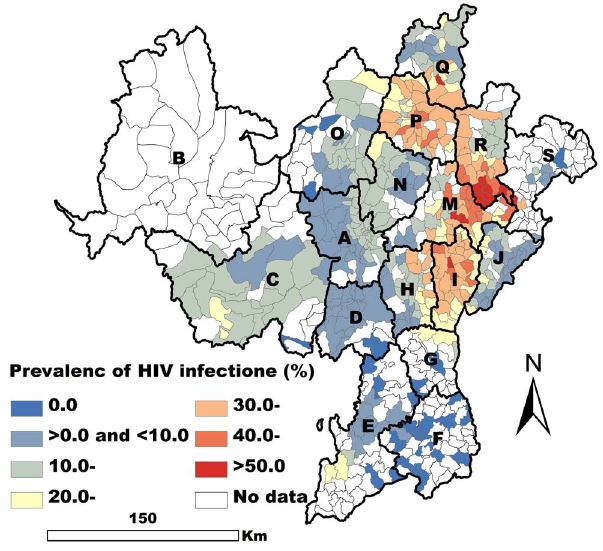
Figure 1. Spatial EB smoothed map of the prevalence of HIV infection by